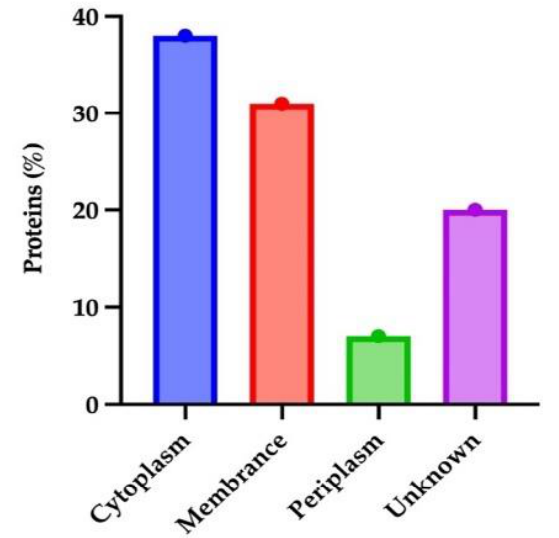
Figure 2. Subcellular localization of vital non-homologous proteins of B. pertussis.